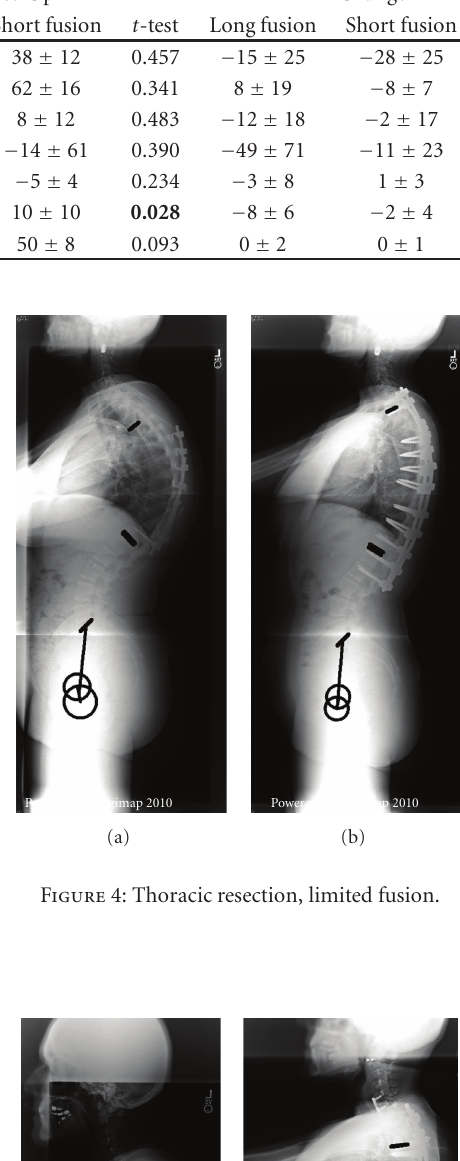
Table 1: Comparison thoracic group—patients that had thoracic PSO. Preoperative and postoperative measurements, P < 0.05 in bold. Thoracic group